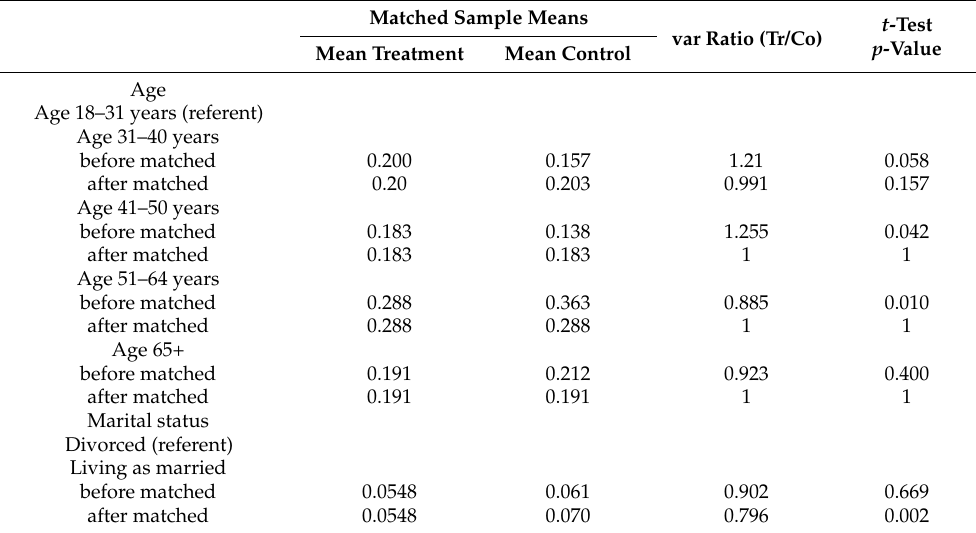
Table A3. The covariate balance of the effect of frequency of using wearable devices on the frequency of moderate intensity exercise for the whole